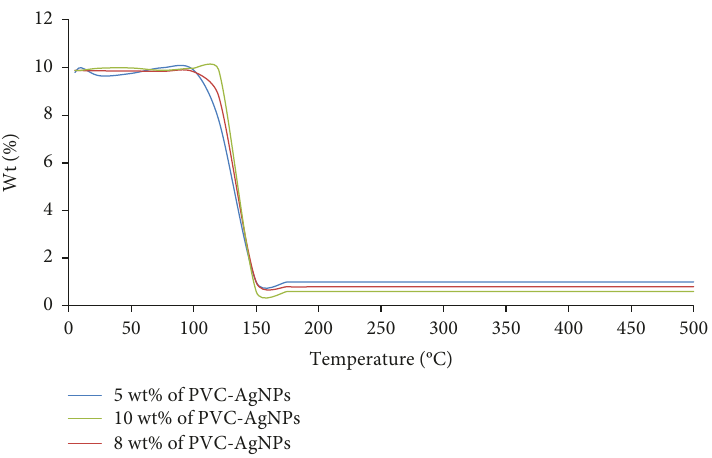
Figure 6: Thermogravimetric analysis of Moringa oleifera oil/PVC-AgNP bionanocomposite fi lms containing di ff erent concentrations of 5wt%-10wt% of